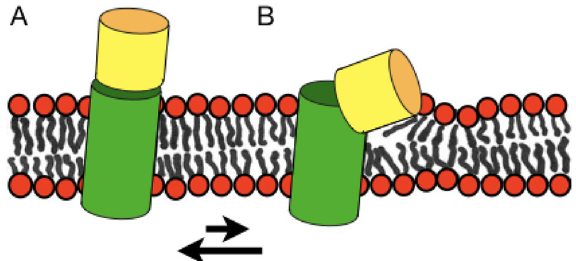
Figure 7. Sketches the conformational flexibility of gp41 where the TMD shown in green and the MPER/ CRAC regions shown in yellow exhibit predominantly helical structures. The protein appears to exhibit considerable conformational flexibility. Whereas the data shown in this paper indicate that both helical domains are aligned in the same direction, possibly forming a continuous structure ( A ), helix-kink-helix conformations have also been observed ( B ). Possibly, the two conformers shown represent different states of the membrane fusion process (see text for